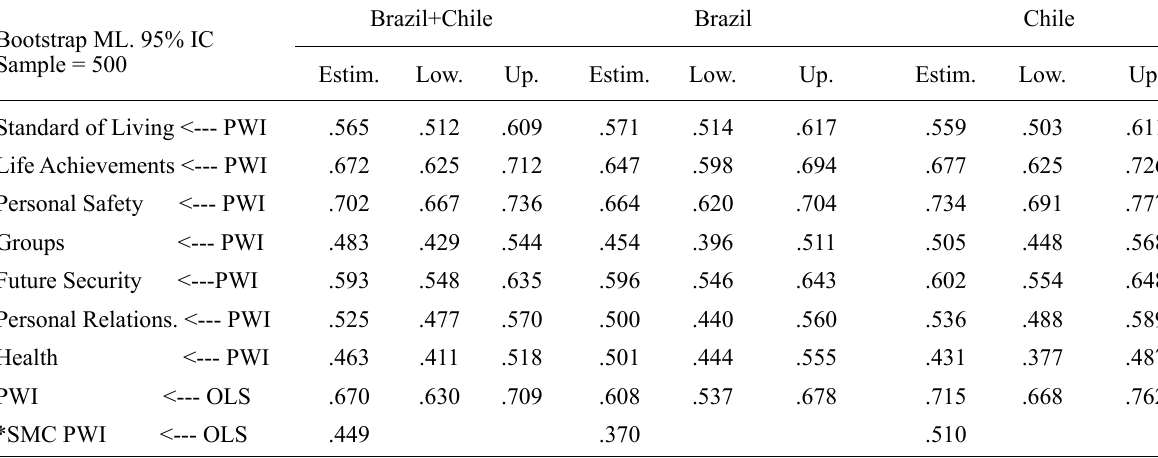
Standardized Estimations – PWI-7